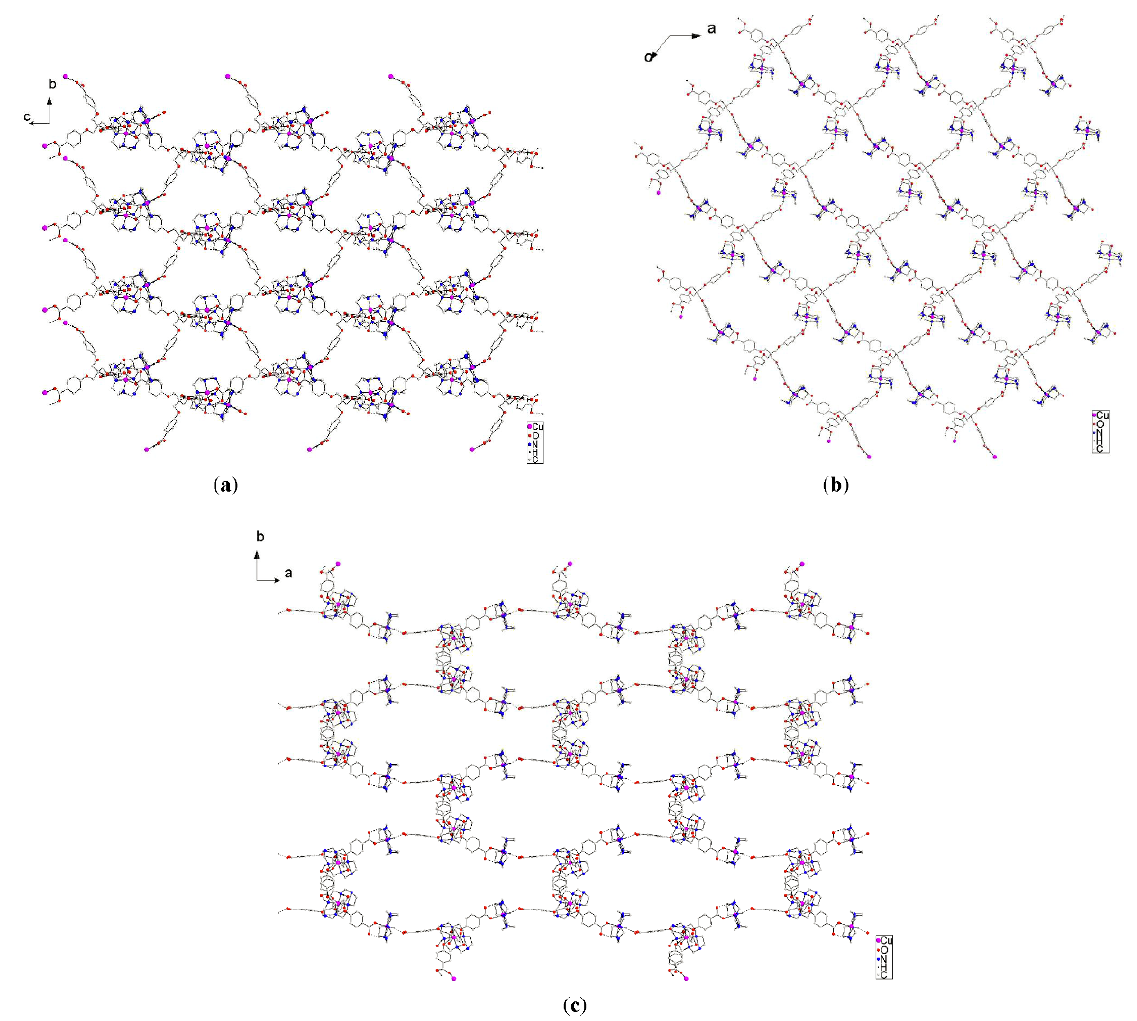
Figure 8. View of the 3D network in the crystal of: (a) along a axis, (b) along b axis, and (c) along c axis (the water molecules are not shown; the broken lines represent hydrogen